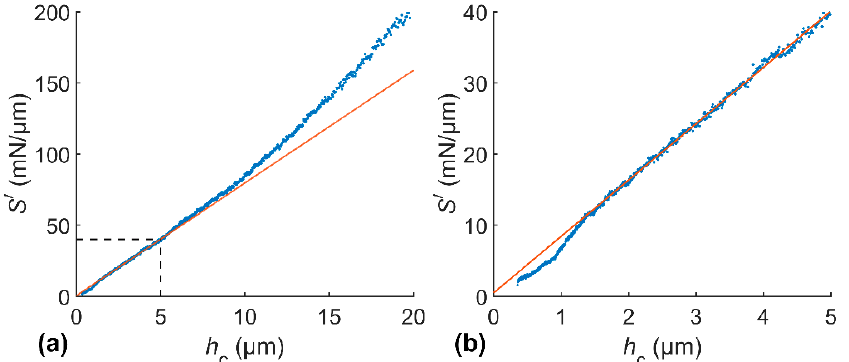
Figure 3. Storage stiffness versus contact depth of a 0.2 mm ‐ thick TiO 2 acrylic paint film on a glass substrate (other results on the same sample shown in Figure 2), deviating from linearity indicated by the red line ( a ) above ~5 μ m caused by the stiffness of the underlying glass substrate and ( b ) below ~1.5 μ m due to the surface roughness of the film.